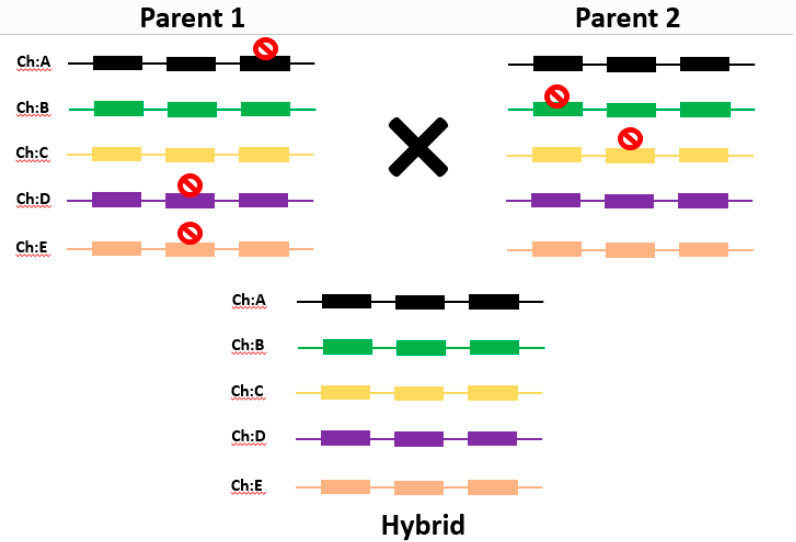
Figure 5. A model of heterosis proposed by Swanson-Wagner et al. [105]. Bars represent genes. Three genes are considered in each hypothetical gene family, situated on different chromosomes. represents “functional block” leading to null or altered protein function. In a real scenario, accumulation of a similar effect with many gene families leads to reduced vigor in inbreeds and heterosis in hybrid. Pangenomics can help to unravel heterosis in a phenotypic trait by discovering new gene variants .